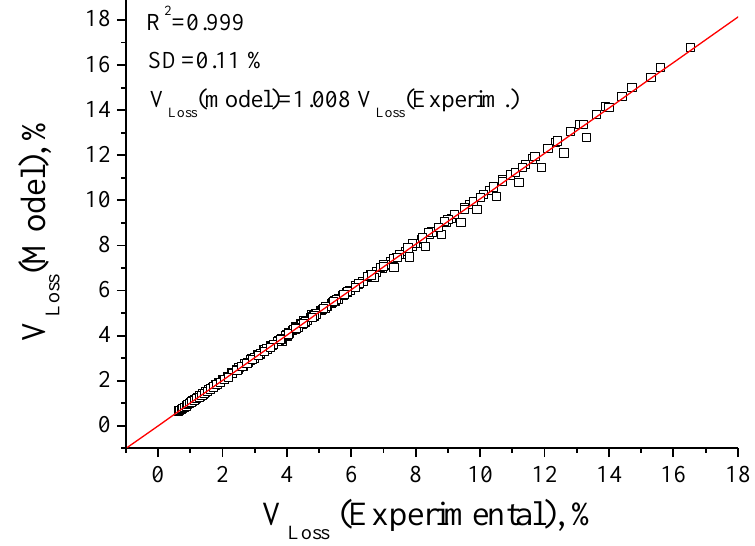
Figure 3. Correlation plot between experimental data and the proposed empiric model (Equation (3)). SD = standard deviation in % of volume loss.